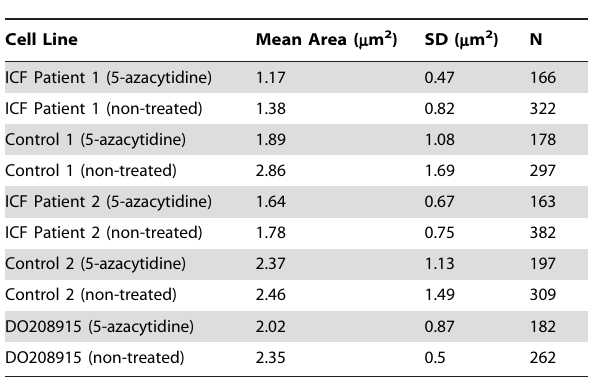
Area measurements of chromosome 1 juxtacentromeric heterochromatin, as defined by hybridisation with the classical satellite DNA probe D1Z1, were carried out on cells from ICF Patients 1 and 2, Controls 1 and 2, and DO208915, a third and unrelated control cell line, before and after treatment with the demethylating agent 5-azacytidine (SD=standard deviation; N=total number of measurements).